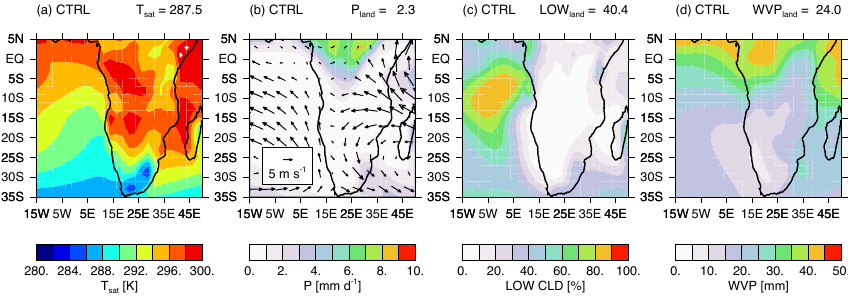
Fig. 5. CTRL case (a) surface air temperature [ T sat ; K], (b) total precipitation [P; mmd − 1 ] and 850-hPa winds [ms − 1 ], (c) low level cloud distribution [%], and (d) column-integrated water vapor [WVP; mm] for ASO. See supplemental material for comparison of these figures to observations and reanalysis data.